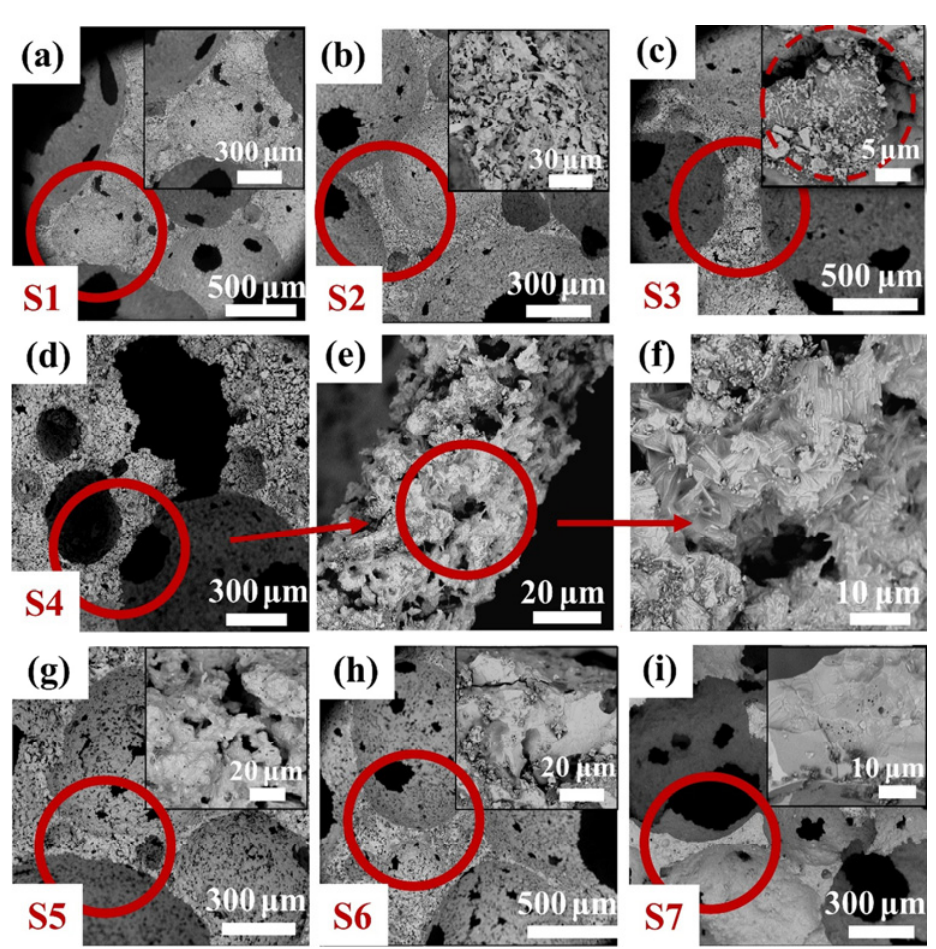
Fig. 7 SEM images for porous samples at various sintering temperatures: (a) S1 (1100